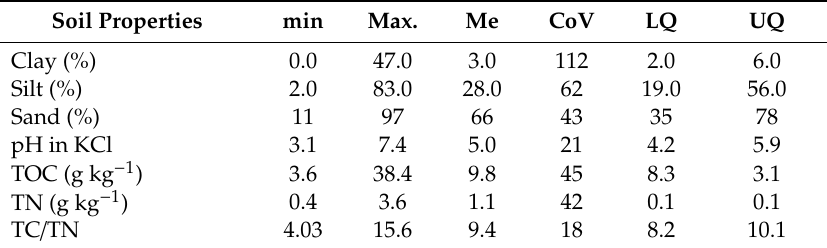
Table 1. Physicochemical soil properties ( n =